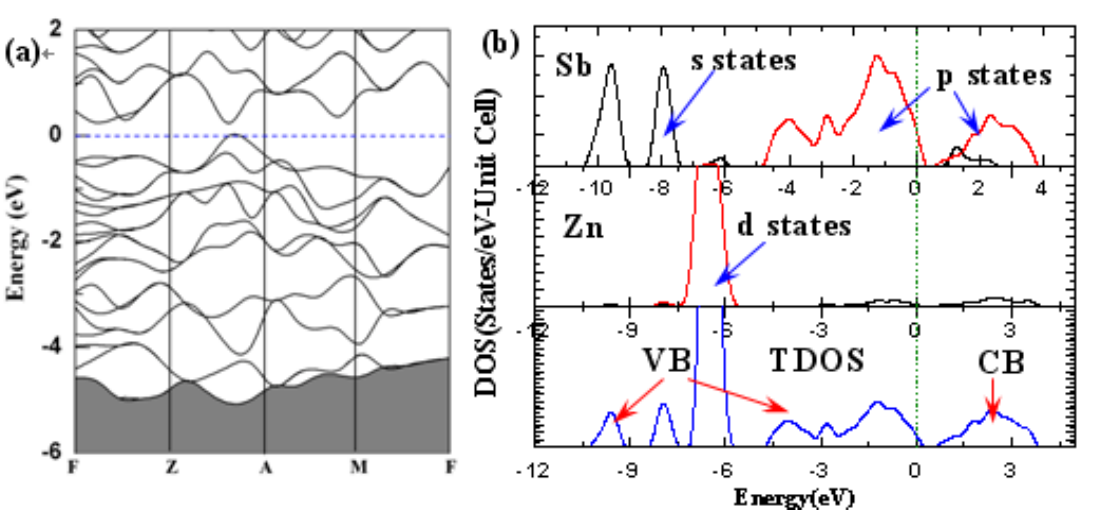
) is set as relative F